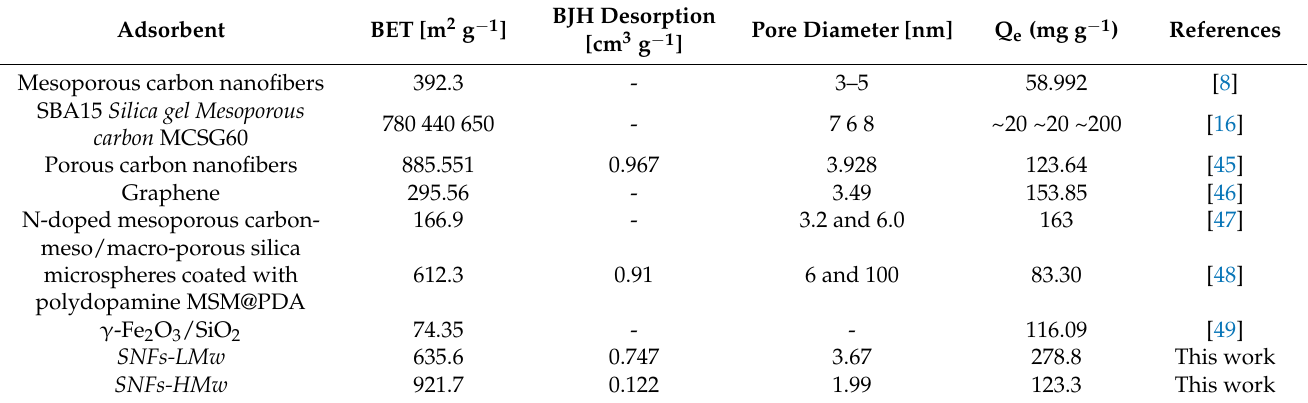
Table 6. Comparison of the MB adsorption capacity of different